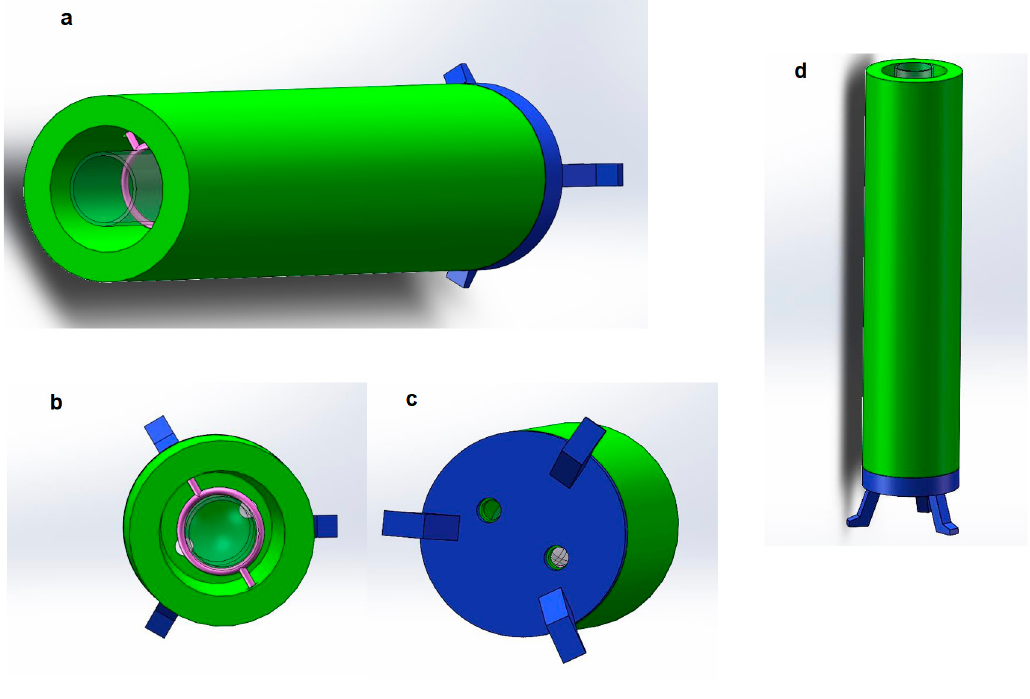
Figure 5. Container (Light chamber) ( a ), container top view ( b ), container bottom view ( c ), container standing on the desk ( d